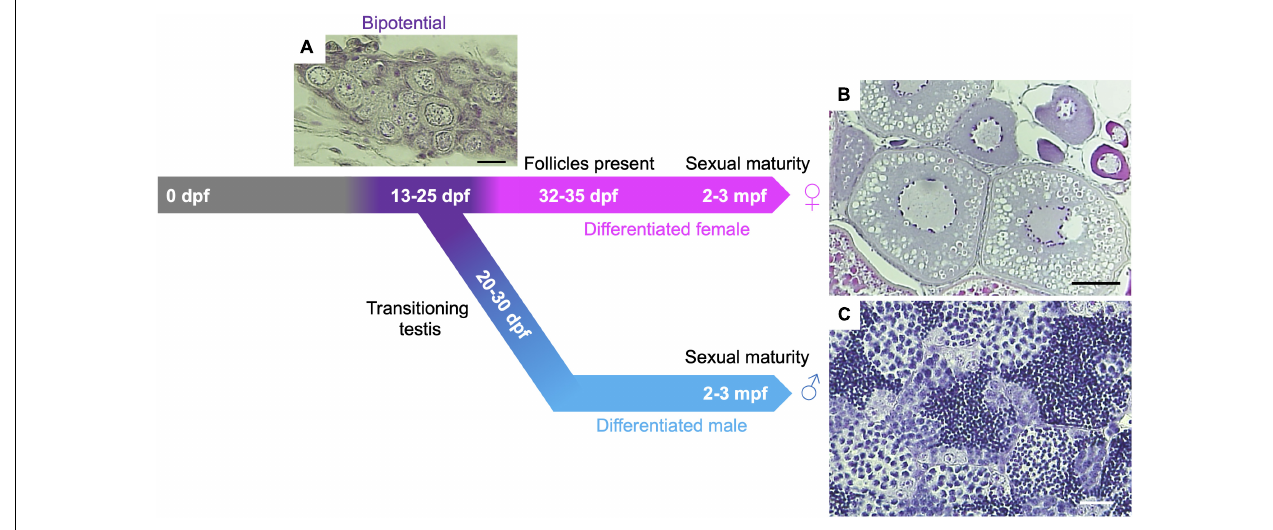
FIGURE 1 | Gonadal sex differentiation and oocyte staging in zebrafish. Adapted from Blokhina et al. (2021). At 13-days post fertilization (dpf) the gonad is considered bipotential (i.e., can develop as either a testis or an ovary) and is made up of pre-follicle and early follicle stages (referred to as stage IA and IB, respectively, based on staging in Selman et al., 1993) and includes cells in meiotic prophase I. Following Stage IA oocyte formation, testis transitioning occurs ∼ 20–30 dpf in roughly 50% of larvae. In this case, oocytes undergo apoptosis and spermatogenesis is initiated. In animals that differentiate as females, oocytes develop further, and Stage IA oocyte production continues through adulthood. (A) Hematoxylin and Eosin (H&E) stained section of 24 dpf gonad. Scale bar = 20 µ m. (B) H&E section of adult ovary. Scale bar = 100 µ m. (C) H&E section of adult testis. Scale bar = 20 µ